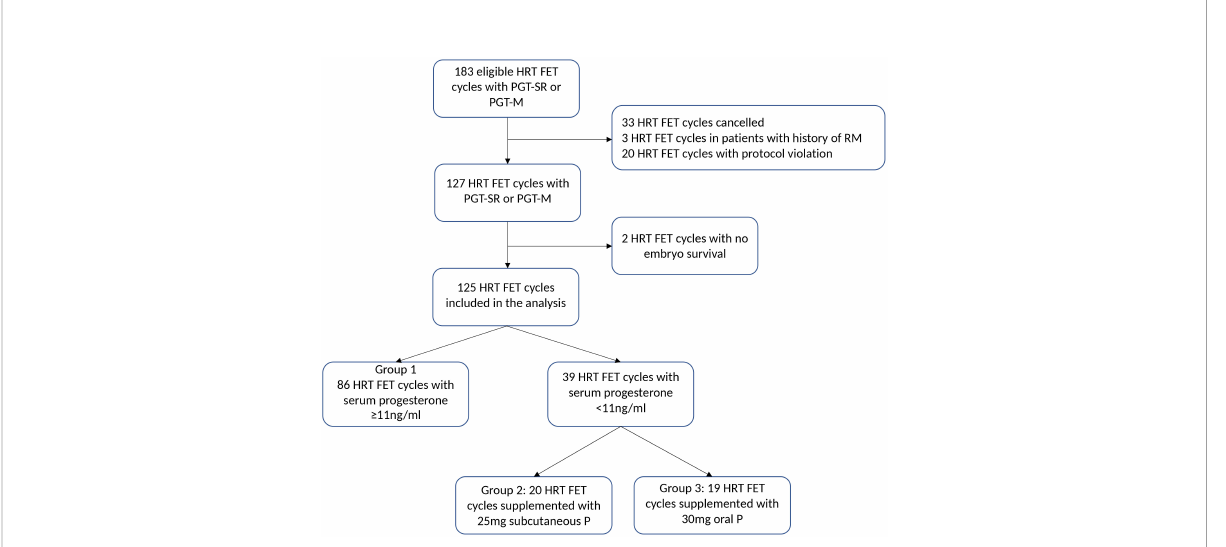
FIGURE 2 Study fl owchart. HRT, hormone replacement therapy; FET, frozen embryo transfer; PGT-SR or PGCT-M, preimplantation genetic testing for structural rearrangement or monogenic disorder; RM, recurrent miscarriage; P,